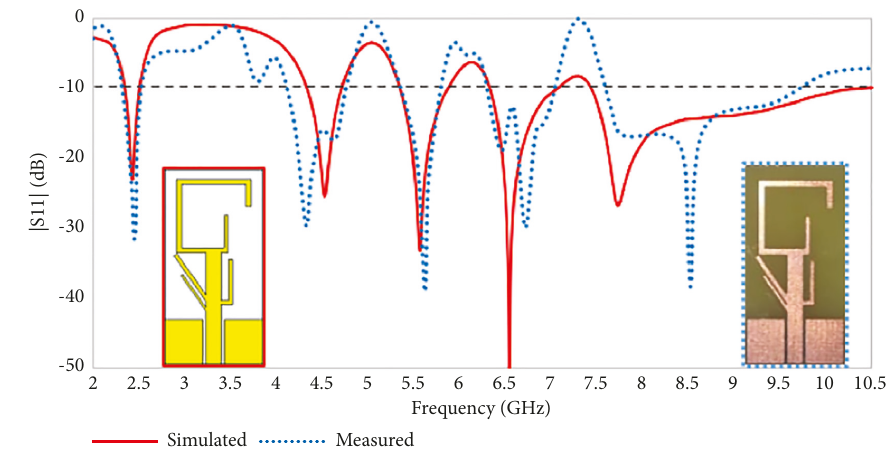
Figure 5: Simulated vs. measured reflection